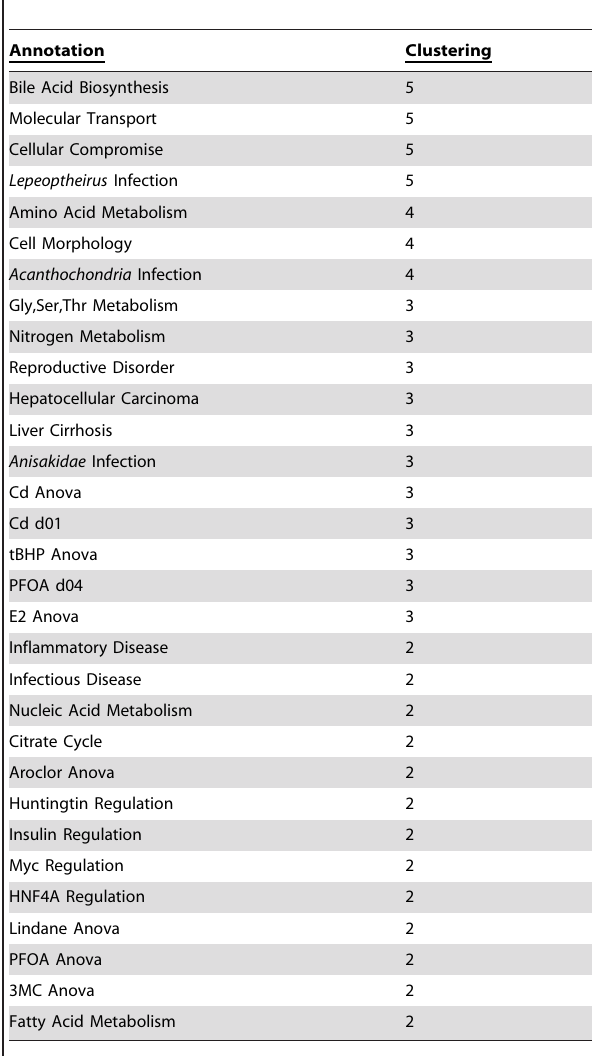
Table 4. Annotation that clustered with environmental site